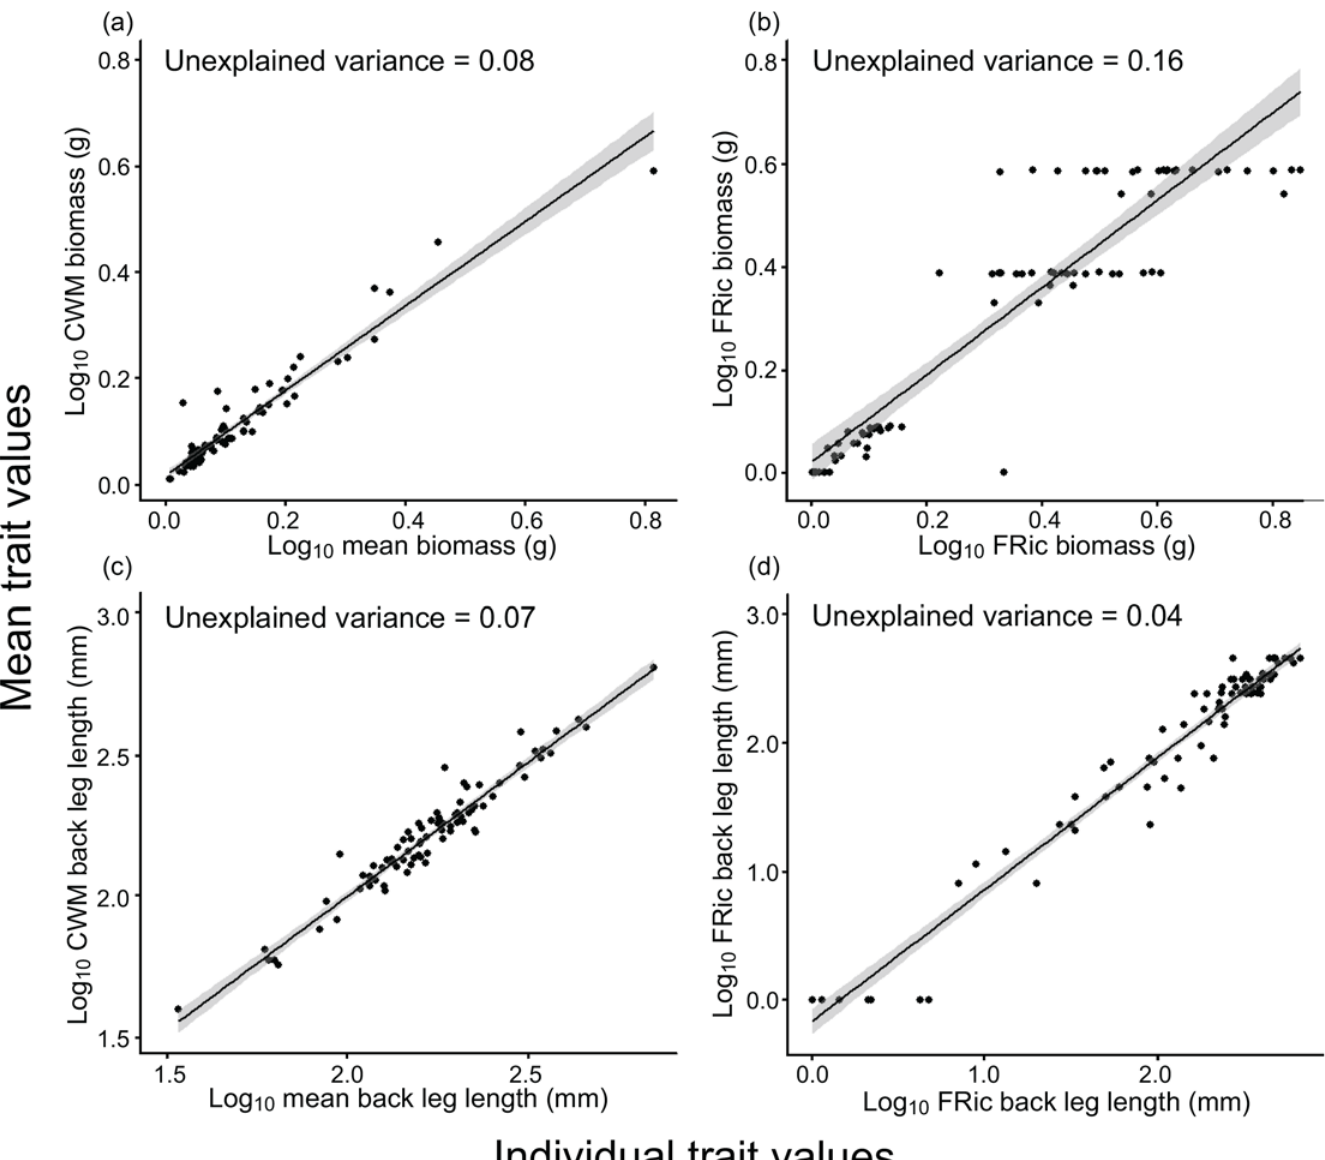
Fig 3. Associations between functional diversity indices calculated with (x – axis) and without (y – axis) the inclusion of intraspecific trait variability. Community weighted mean (CWM) of body mass (a), functional richness (FRic) of body mass (b), CWM back of back leg length (c) and FRic of back leg length (d). Linear model outputs are displayed: regression lines (solid back lines), standard errors (grey ribbons) and the inverse of R 2 values to describe the loss of information as a result of exclusion of intraspecific trait information.